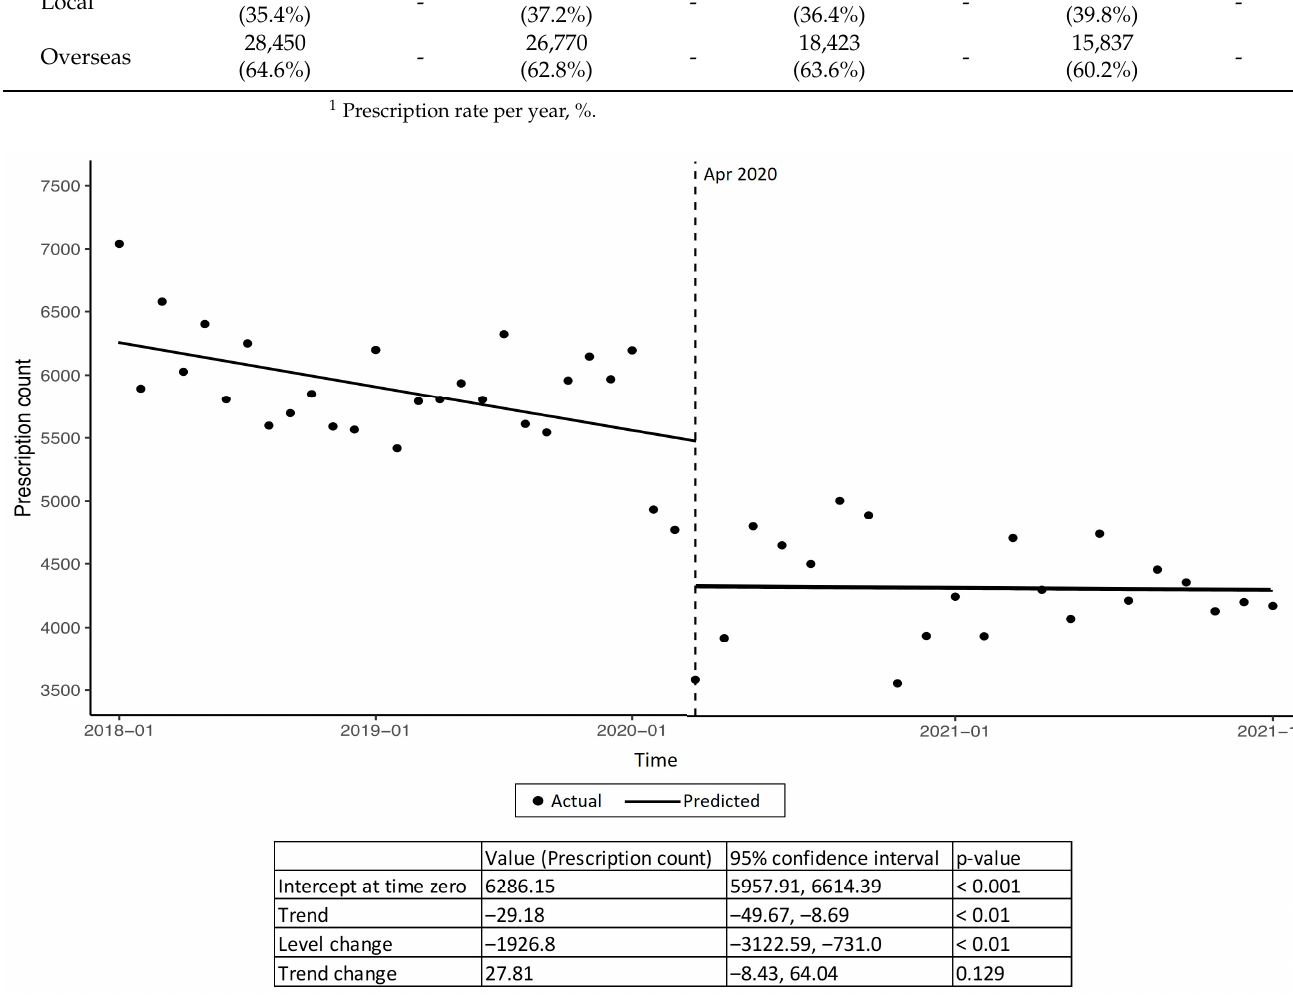
Figure 1. Segmented regression analysis of oral antibiotic prescriptions from 2018 to 2021 (April 2020 was observed as the peak of COVID-19 pandemic in Singapore). Oral antibiotics were most prescribed for respiratory conditions (29.6%), skin and soft tissue conditions (28.9%), and genitourinary conditions (15.2%) (Table 2). In 2021, skin and soft tissue conditions (37.7%) and genitourinary conditions (20.2%) overtook respiratory conditions to become the top two most common conditions when oral antibiotics were prescribed. This was due to an 84% reduction in respiratory antibiotic prescriptions, with a 5.22% absolute reduction in respiratory condition visits prescribed with oral antibiotics (Figure